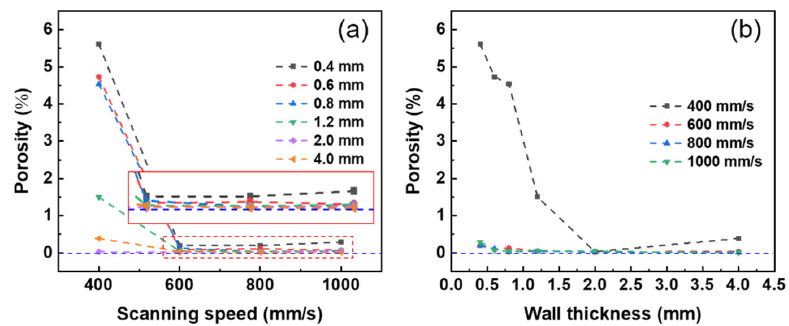
Figure 3. The evolutions of porosity with ( a ) scanning speed and ( b ) wall thickness. Table 1. The relative density of samples with different wall thickness and scanning speeds. Relative Wall Thickness